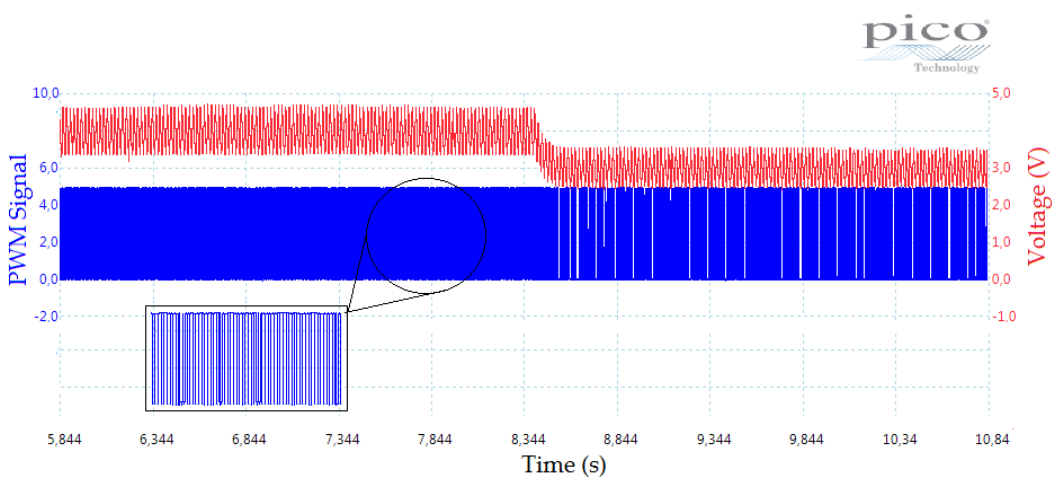
Figure 15. Control signal (blue) by using the P&O algorithm and PV voltage under irradiation change (red).